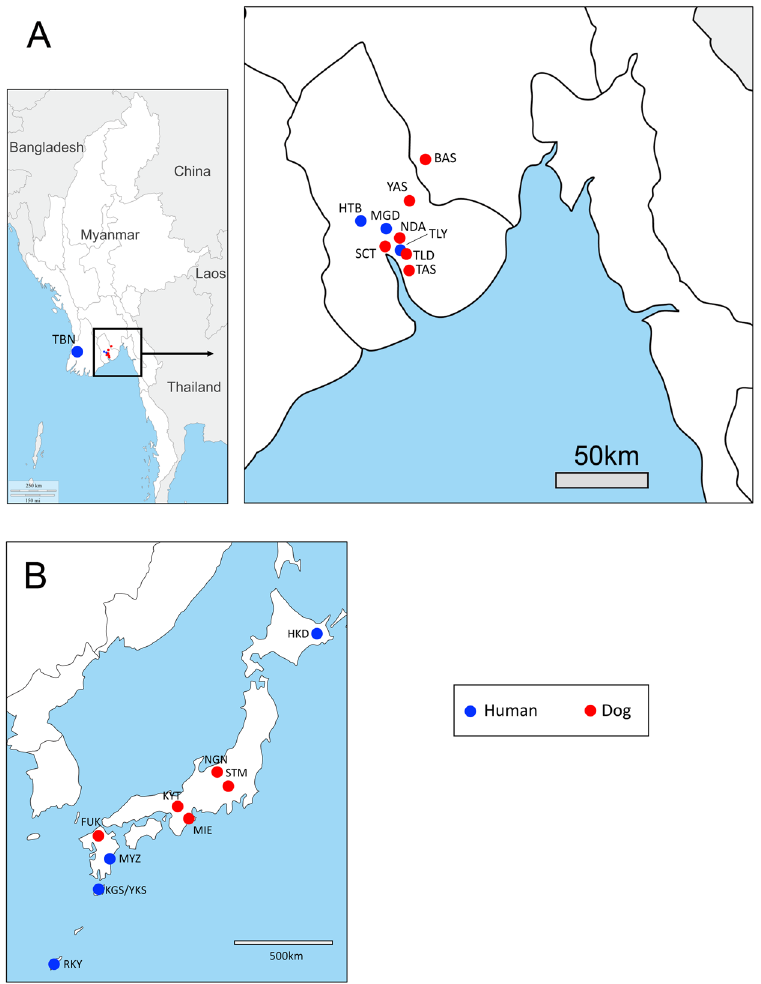
Figure 5. Map of Myanmar and Japan showing the geographical origin of the Strongyloides nematode samples. Maps were created with Adobe Creative Suite 5.5 and Microsoft PowerPoint version 15.22 from templates obtained from d-maps.com. (Myanmar: http://www.d-maps.com/carte.php?num_car = 4162&lang = en, Japan: http://www.d-maps.com/carte.php?num_car = 74&lang = en). Three-letter codes indicate sampling locations. Further details of each sampling location are summarized in Table